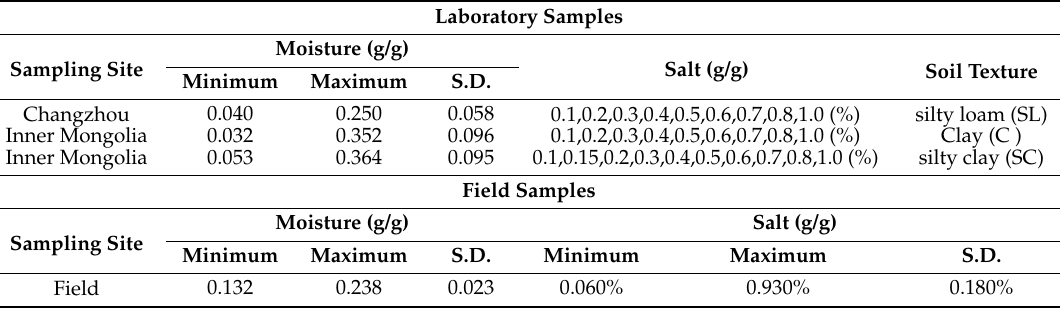
Table 1. Soil moisture, salt and texture characteristics of synthetic laboratory and field soil samples. (S.D. = standard deviation)